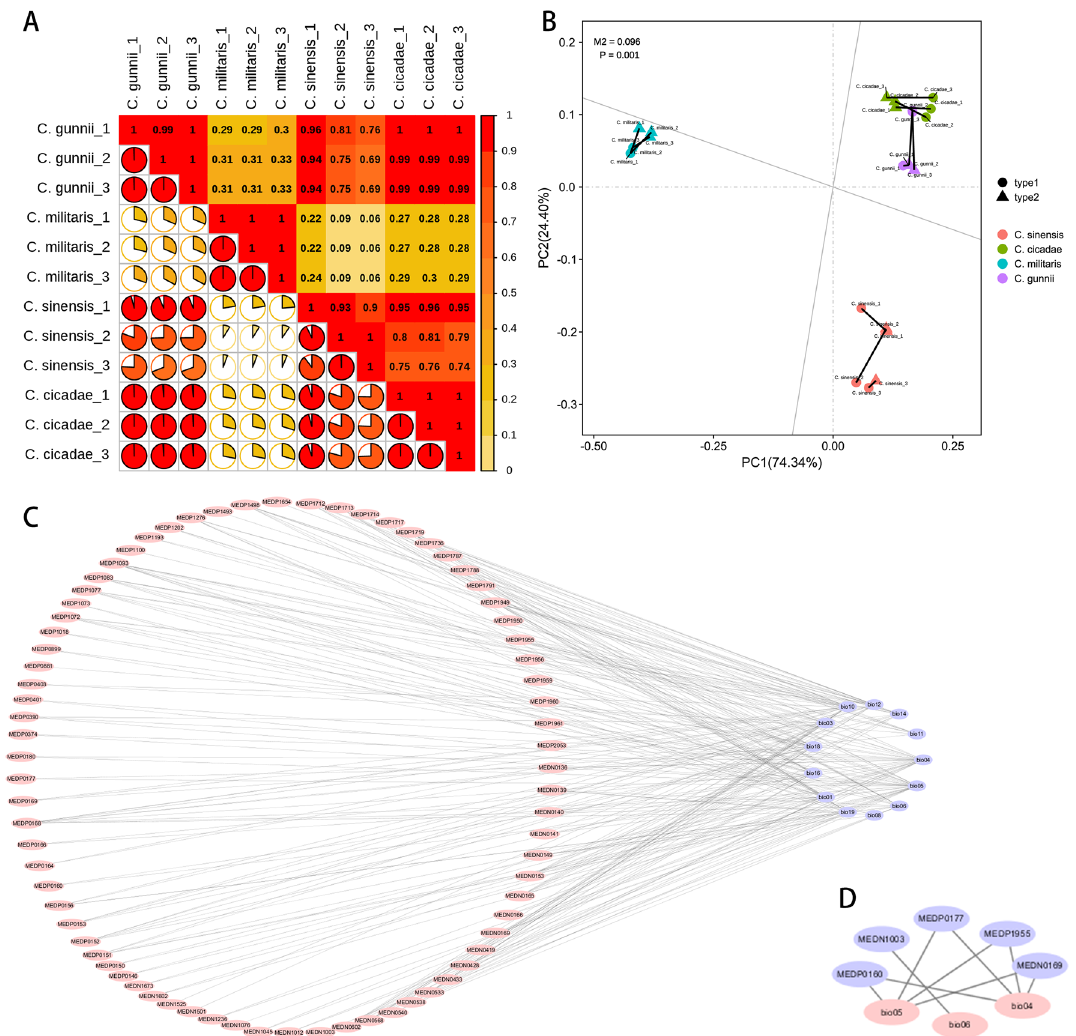
Figure 6. ( A ) Analyze the interspecific correlation heat map of C. sinensis , C. cicadae , C. militaris and C. gunnii according to ecological climate factors. ( B ) The results of the Platts analysis of ecoclimate factors and nucleoside metabolites. (type1: ecoclimate factors, type2: nucleoside metabolites.) ( C ) Network diagram of correlations between eco-climate factors and nucleoside metabolites. ( D ) Correlation network diagram of eco-climate factors and major components in nucleoside